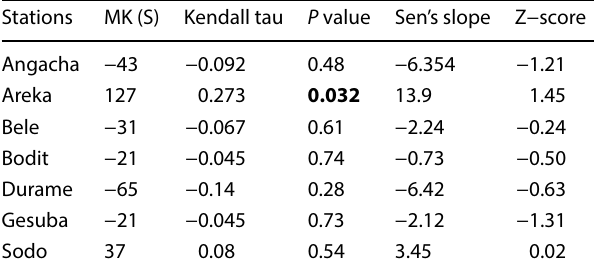
Table 5 MK test result for monthly and seasonal